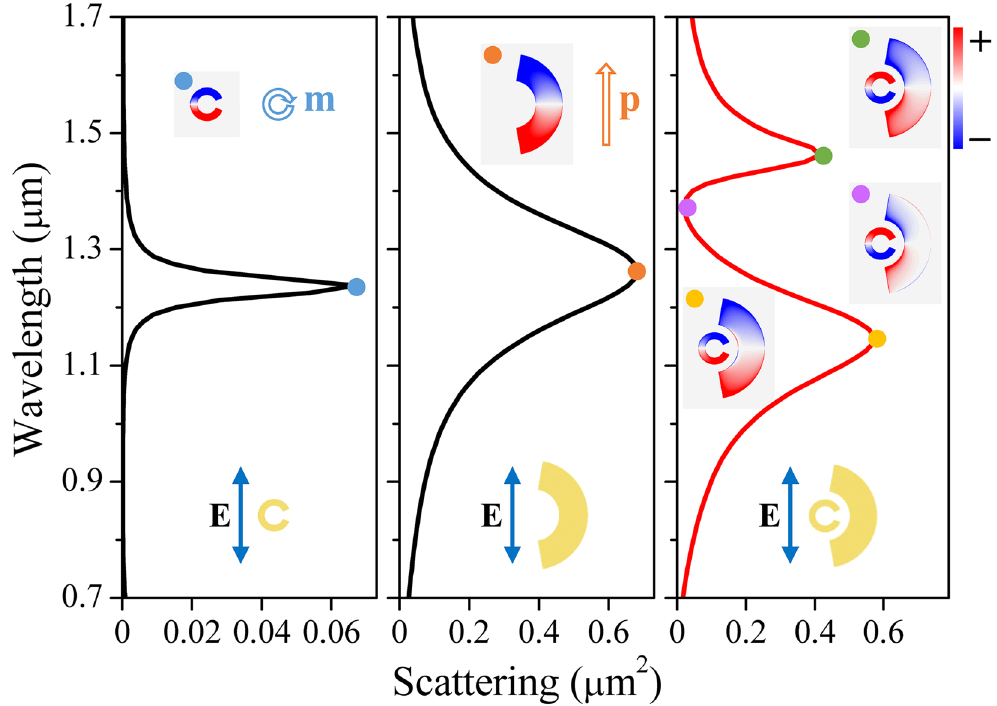
Figure 2. Scattering spectra of SRR (left), nanoarc (middle) and the combined structure (right) with the illumination of linearly polarized beam (LPB). The upper and lower insets are the charge distributions at the labeled wavelengths and the polarizations of the excitation field.